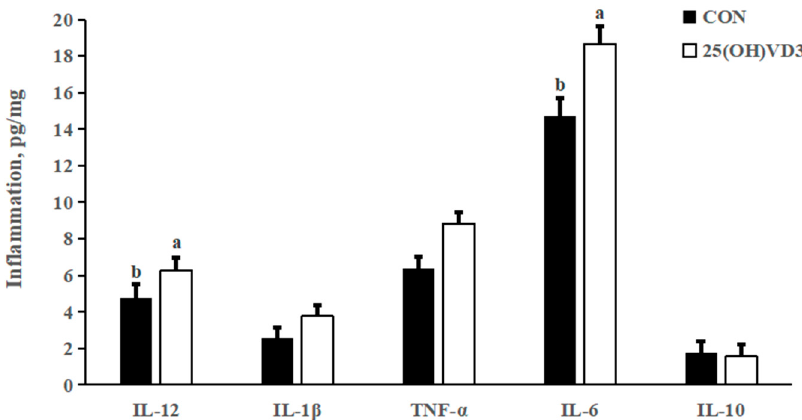
Figure 1. Effects of 50 µ g/kg 25(OH)VD 3 on inflammatory cytokines concentration in the liver of